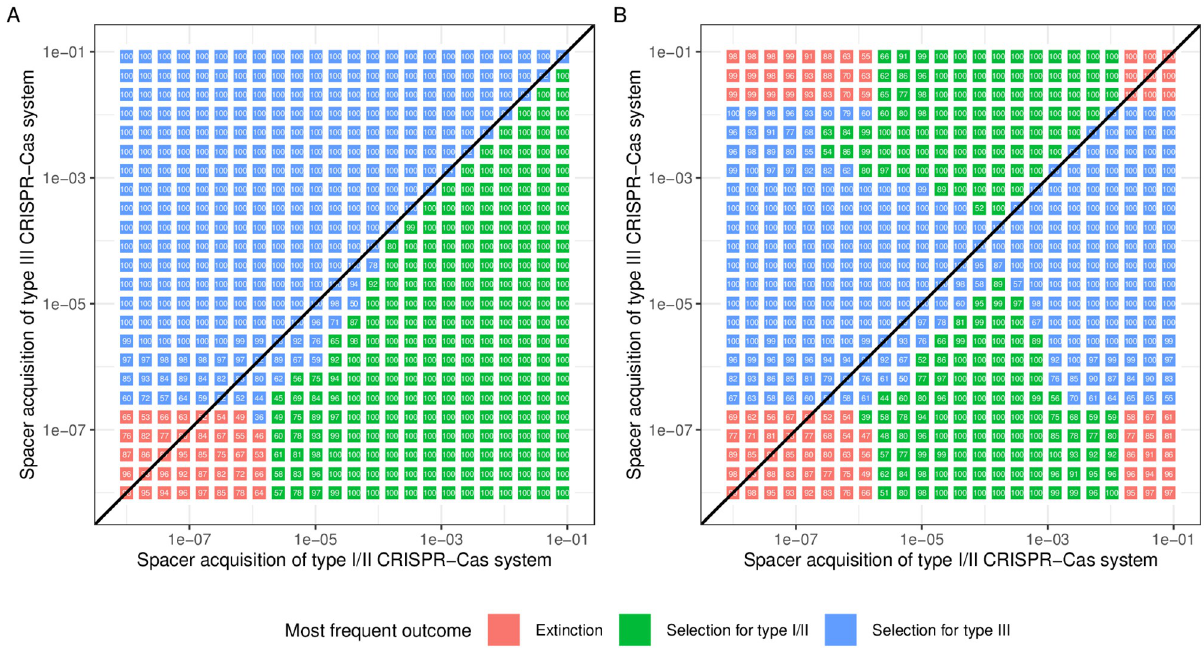
Fig 6. Competitions between type I/II and type III CRISPR-Cas systems. A population of two strains of susceptible bacteria, one carrying a type I/II CRISPR-Cas system and one carrying a type III CRISPR-Cas system, is infected by a virulent phage. For each pair of probability of acquisition, we simulated 100 outbreaks without A) or with B) autoimmunity-induced death (Propensity = 40). We report the most frequent outcome (Extinction of the two strains, Selection for type I/II or Selection for type III) and provide the number of simulations in which this outcome occurred (see numbers in